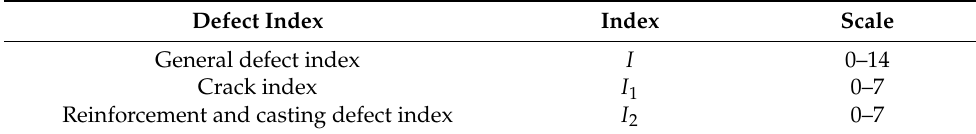
Table 2. Defect indexes used to assess the quality of the